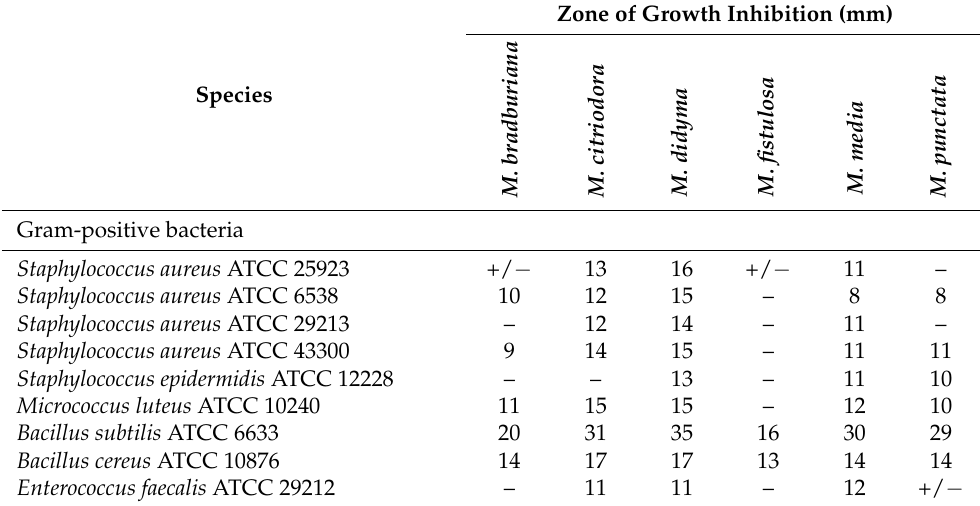
Table 2. Antimicrobial activity of 70% ( v/v ) methanolic extracts of Monarda species by diffusion method based on growth inhibition zone diameters